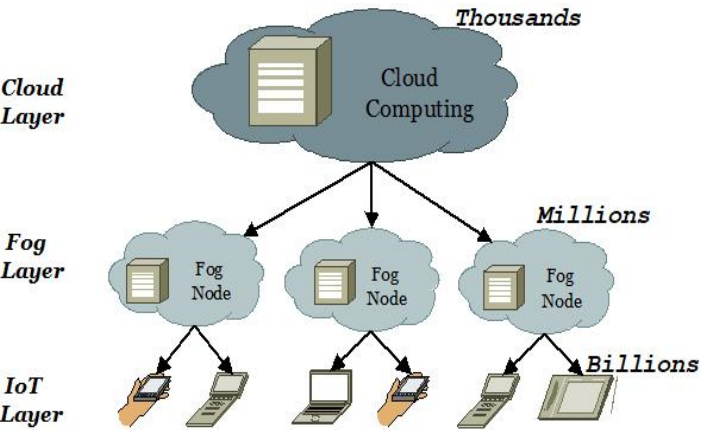
Figure 1. The IoT-Fog-Cloud integration.